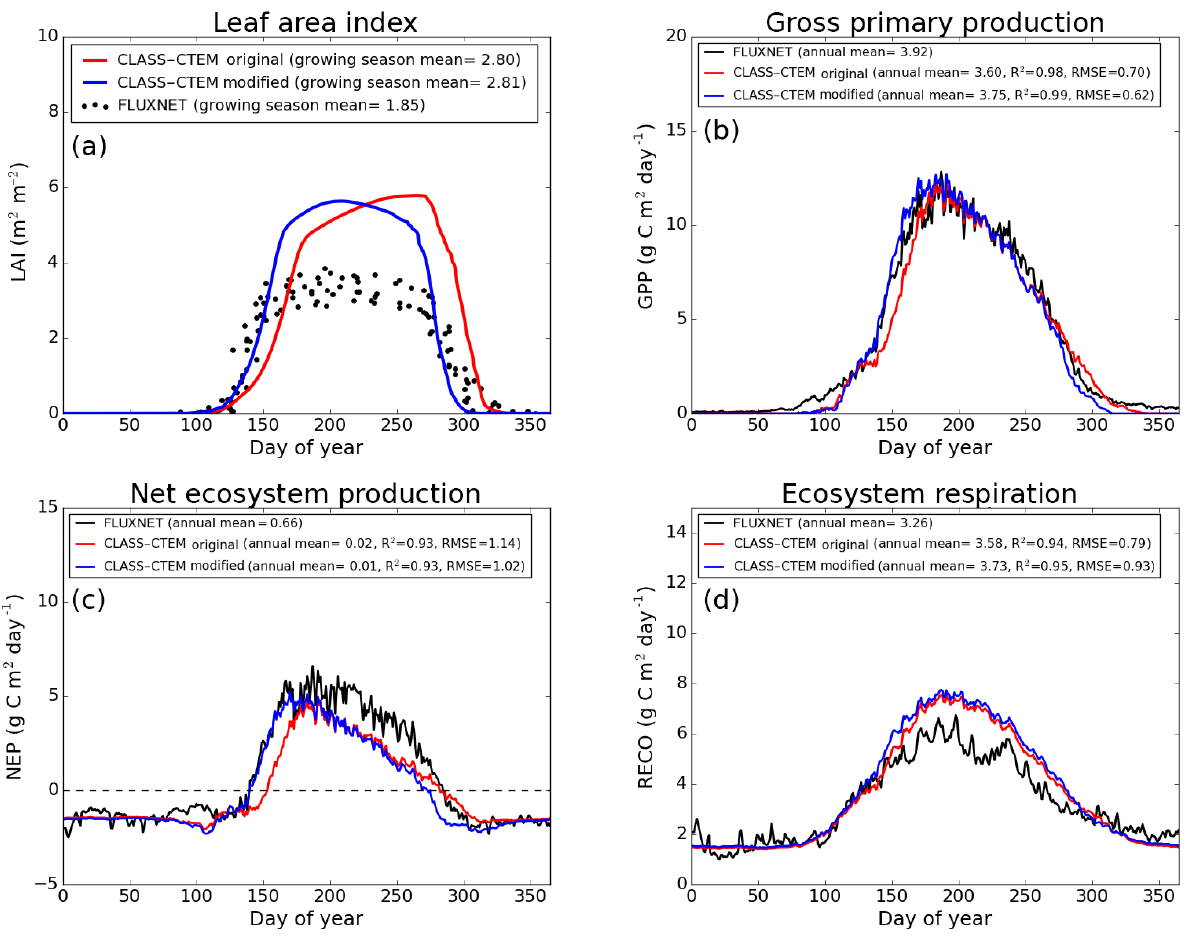
Figure 4. Observed and CLASS–CTEM-simulated averaged daily values of (a) LAI (m 2 m − 2 ), (b) GPP (gCm − 2 day − 1 ), (c) NEP (gCm − 2 day − 1 ), and (d) ecosystem respiration (gCm − 2 day − 1 ) for the US-Ha1 (Harvard Forest) FLUXNET site across all years when data are present. Legends also show the mean annual value of the quantity plotted, except for LAI, which is averaged over the growing season. Root-mean-square error (RMSE) and coefficient of determination ( R 2 ) are also shown for simulated values when compared to observation-based